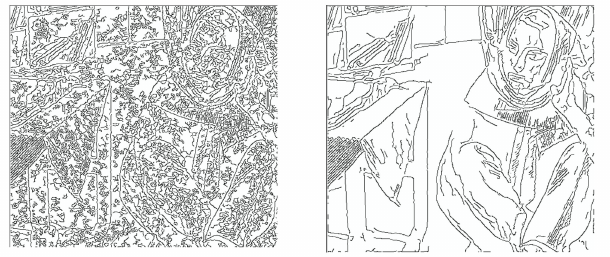
Figure 5. Comparison of Canny’s detector applied directly on noisy image ( left ) and proposed edge detection method ( right ) for—. σ n = 30.